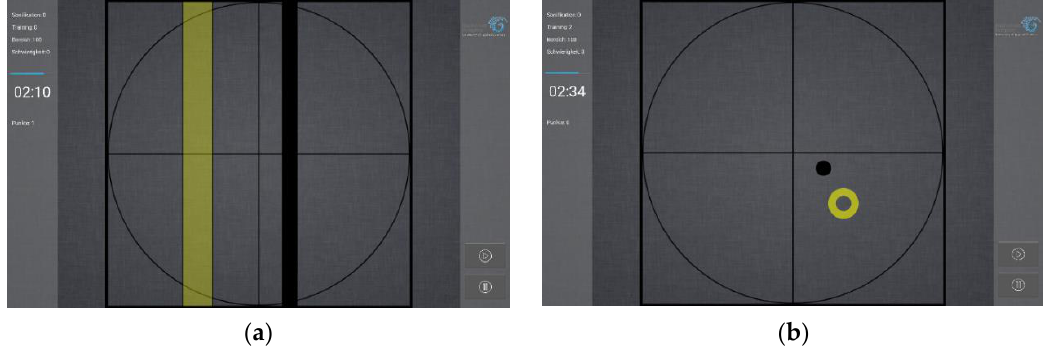
Figure 3. Visual display for the target finding exercise in E1 ( a ) and E2 ( b ).